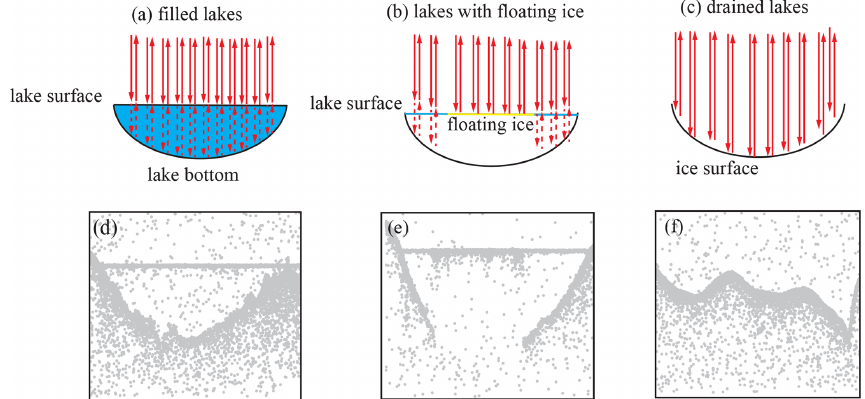
Figure 2. Example of how ICESat-2 can penetrate through the water column of supraglacial lakes to measure the lake bottom. The solid and dashed lines indicate strong and weak reflections, respectively. Panel (b) shows an example of a surface lake with floating ice. ICESat-2 can only penetrate the lake surface, but reflects directly off the floating ice. Panel (c) shows an example of a drained lake of which ICESat-2 directly measures the ice surface. The second row (d–f) shows examples of the ICESat-2 photon reflection for the corresponding schematic.